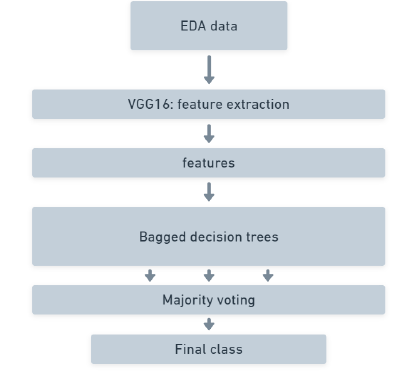
Figure 2: Conductance measurement. Example of data reported as disgust.